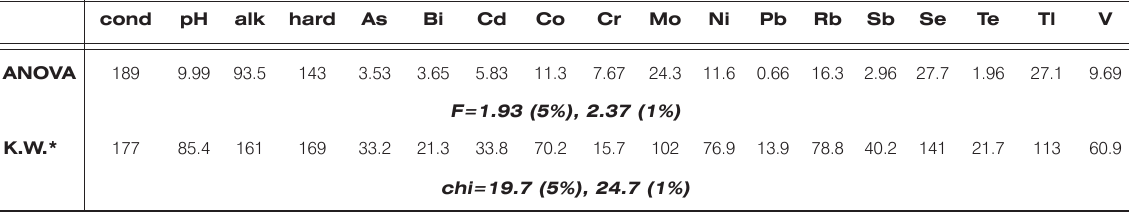
– differences between two 1